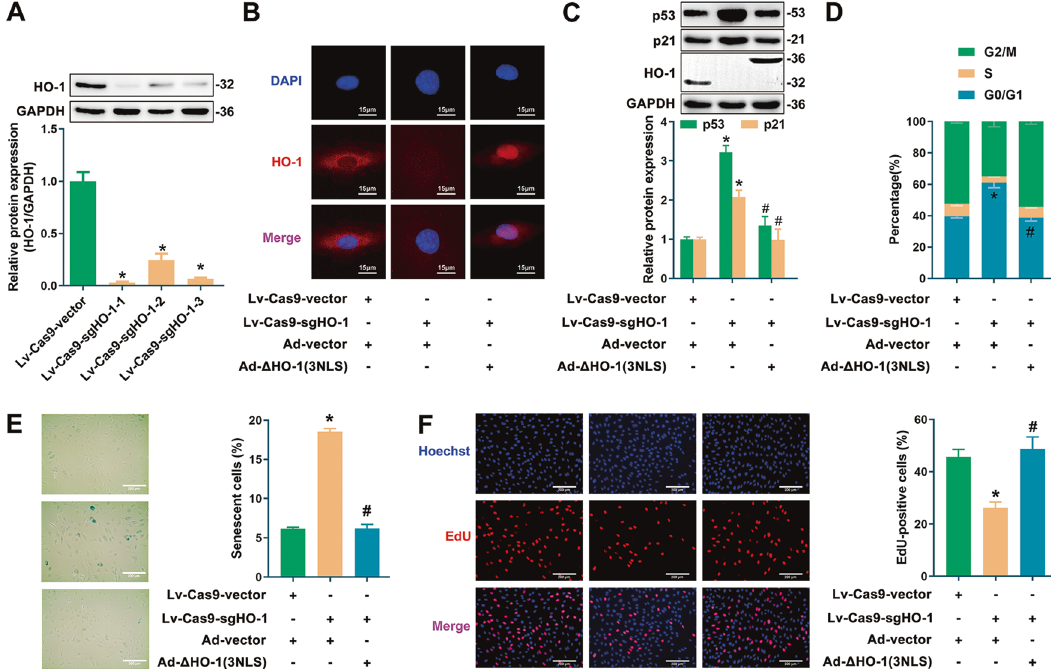
Fig. 3 Overexpressing nuclear HO-1 after knockdown of endogenous HO-1 resisted endothelial senescence. A De fi cient ef fi ciency of sgRNAs was tested. * P < 0.05 vs. Lv-Cas9-Vector. n = 5. B Fluorescence signal of HO-1 was detected. n = 3. C HO-1 knockdown by CRISPR-Cas9 increased the expression of p53/p21, but was reversed by Ad-HO-1(3NLS). * P < 0.05 vs. vector; and # P < 0.05 vs. Lv-Cas9-sgHO-1. n = 3. D Infection with Ad-HO-1(3NLS) ameliorated G0/G1 cell cycle arrest induced by HO-1 knockdown. * P < 0.05 vs. vector; and # P < 0.05 vs. Lv-Cas9- sgHO-1. n = 5. E Infection with Ad-HO-1(3NLS) reversed the increasing proportion of SA- β -gal-positive cells induced by HO-1 knockdown. * P < 0.05 vs. vector; and # P < 0.05 vs. Lv-Cas9-sgHO-1. n = 5. F Infection with Ad-HO-1(3NLS) reversed the decreasing ratio of EdU-positive cells induced by HO-1 knockdown. * P < 0.05 vs. vector; and # P < 0.05 vs. Lv-Cas9-sgHO-1. n =